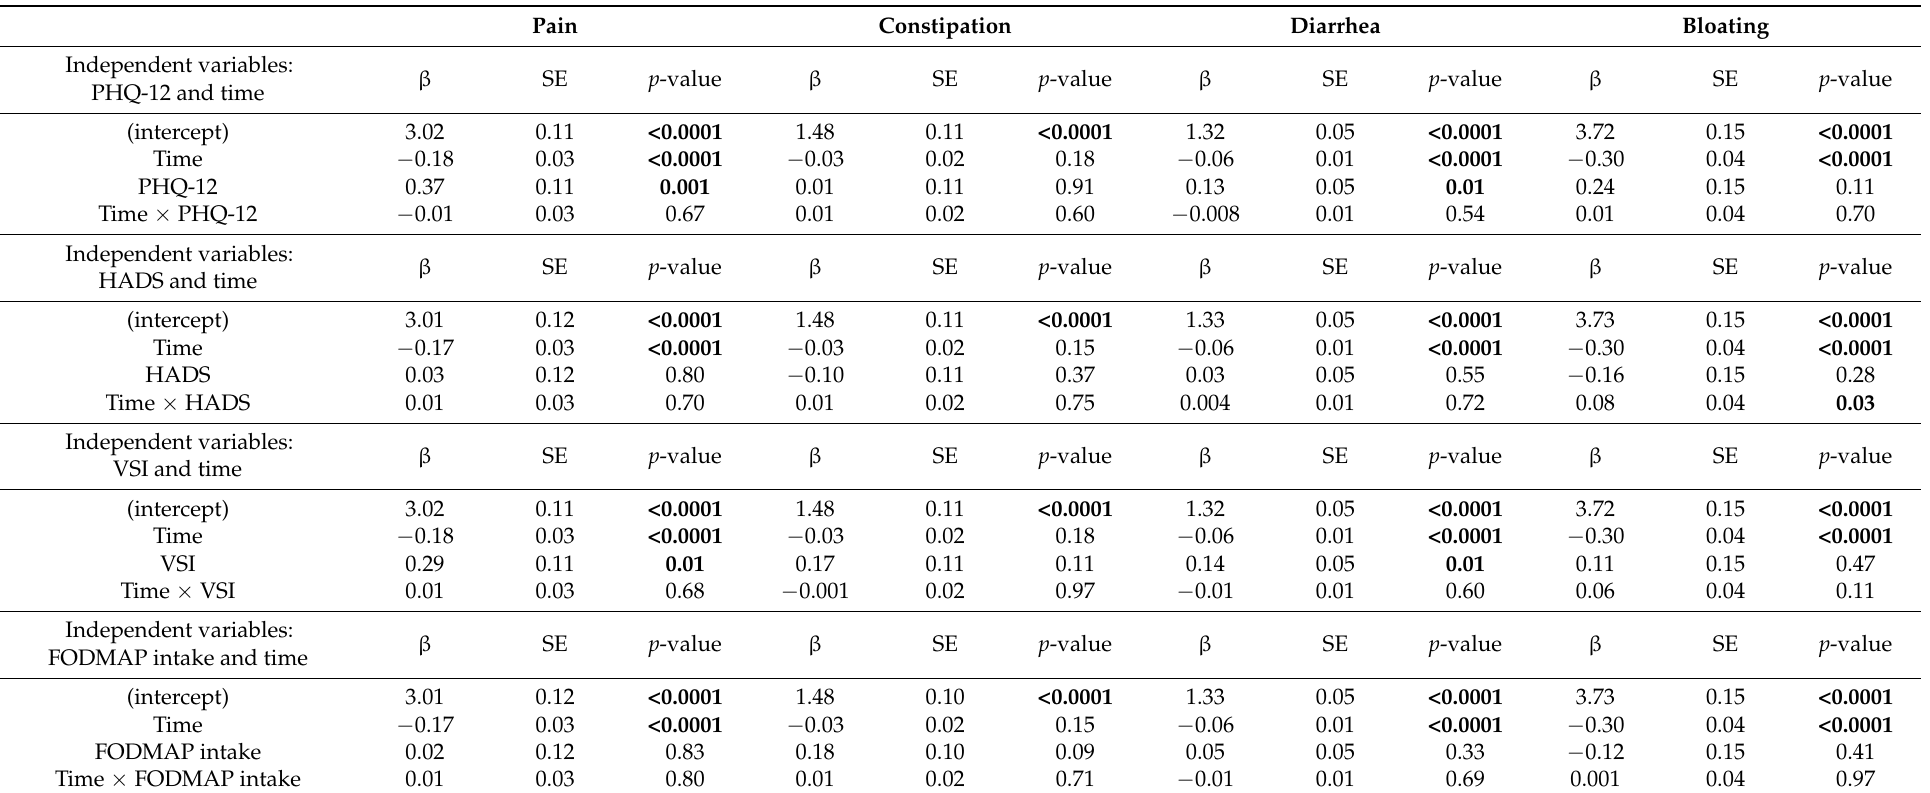
Table 2. Mixed linear random-effect models without diet effects and GSRS-IBS subscales as outcome *. Pain Constipation Diarrhea